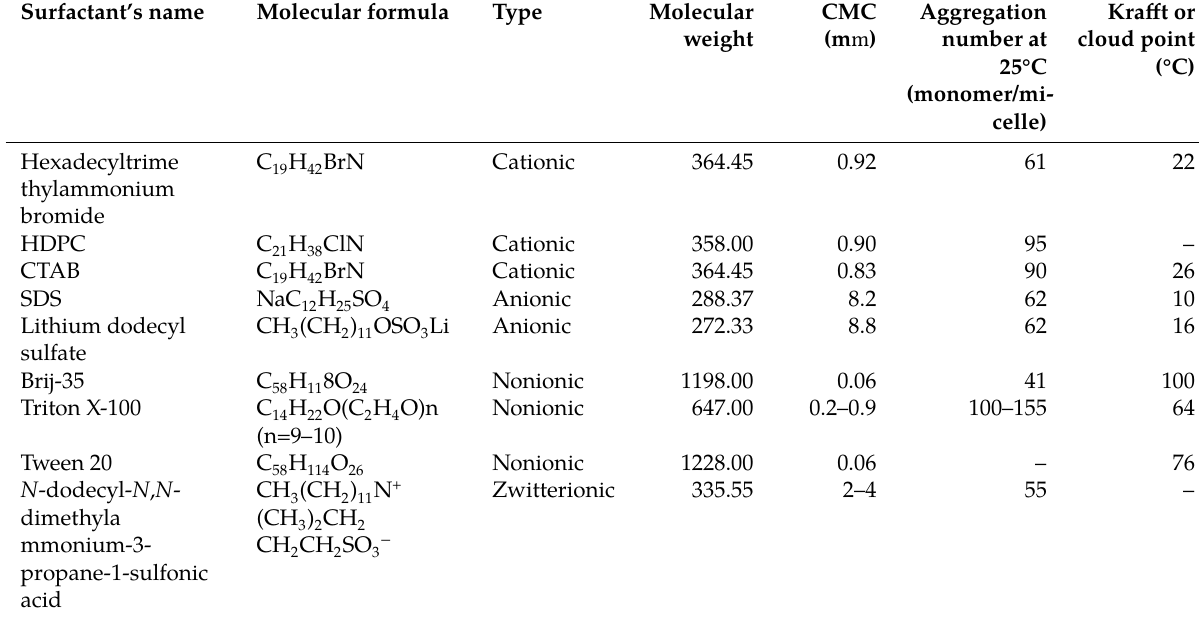
Table 1: Characteristics of some commonly used ionic and nonionic surfactants a (Armstrong, 1985; El-Shaheny, El- Maghrabey & Belal,